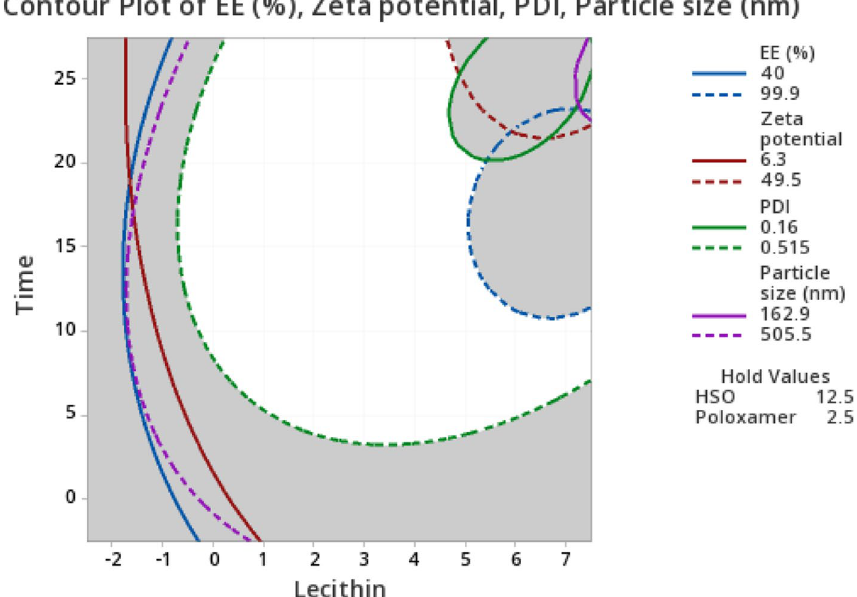
Figure 3. Contour plot of process time (min) and Lecithin (%) for entrapment efficiency (%), Zeta potential (ζ) mV, PDI and particle size (nm).